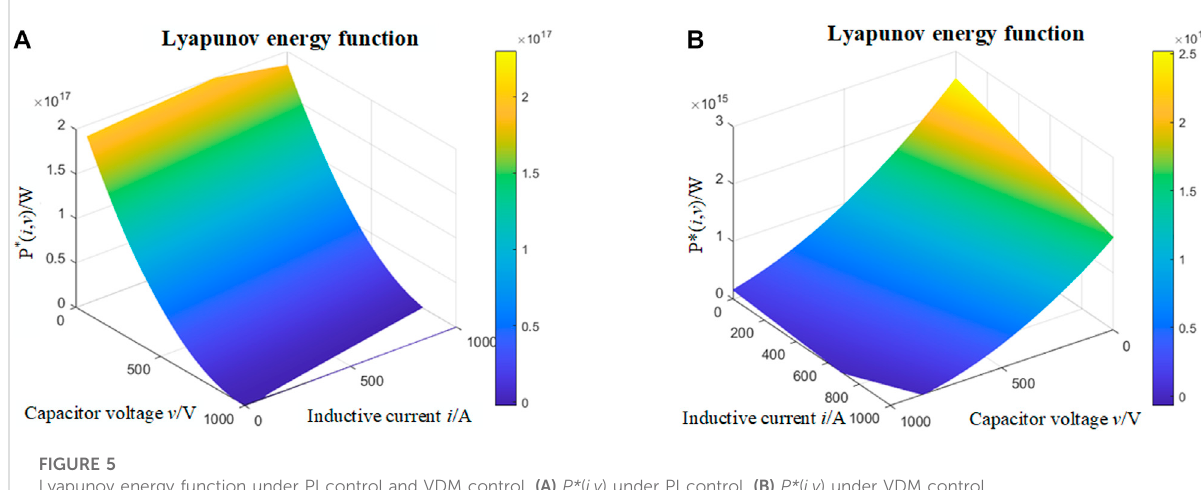
FIGURE 5 Lyapunov energy function under PI control and VDM control. (A) P* ( i , v ) under PI control. (B) P* ( i , v ) under VDM control.